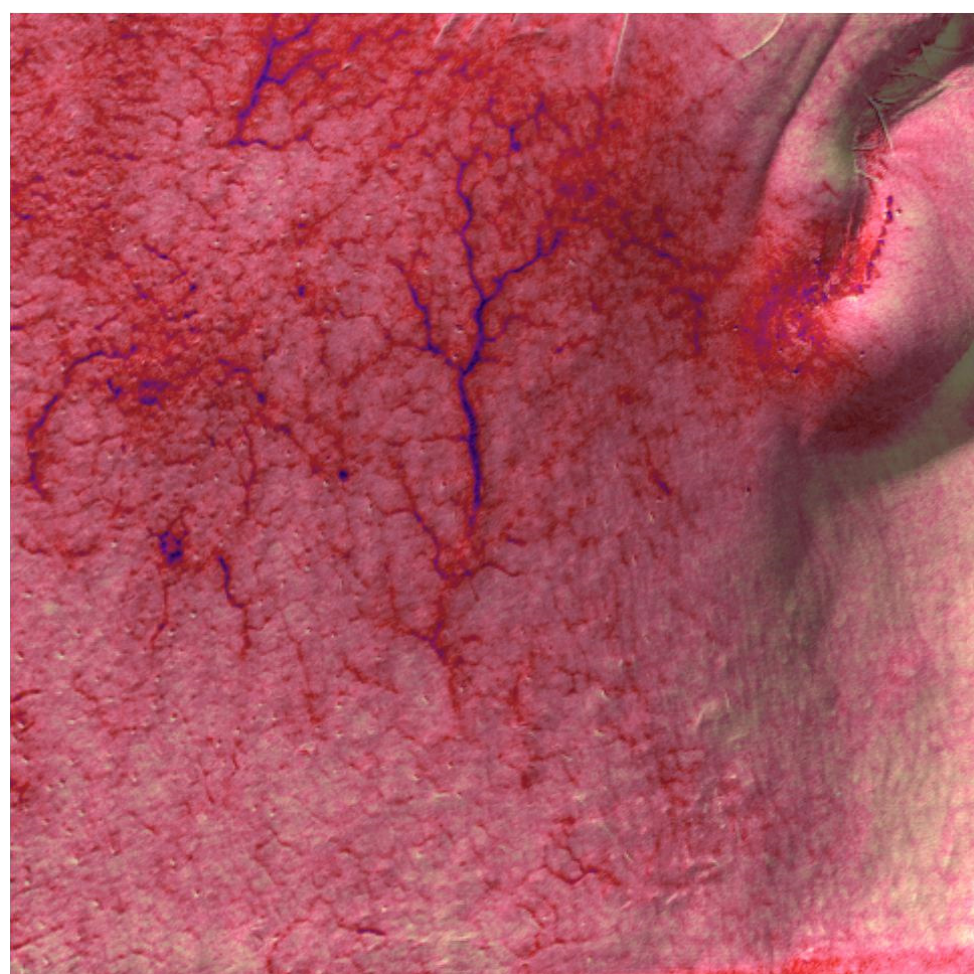
Figure 3. Patient n. 33 multispectral analysis before all treatments.